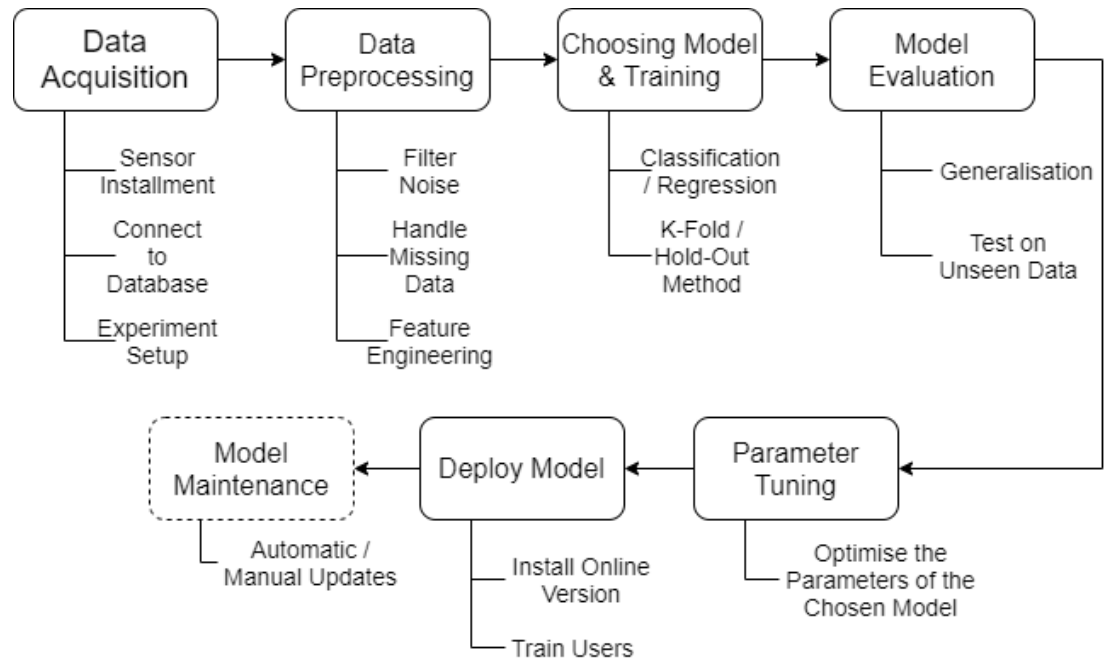
Figure 4. An overview of the process for developing a successful machine learning model, be it in a PdM setting or